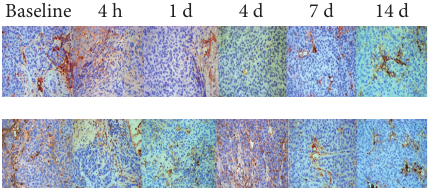
Figure 7: CD34 staining ( × 400) of the tumor at baseline, 4h, 1, 4, 7, and 14 days after treatment in the two groups. From 4 hours and day 1 to day 4, a decrease in the tumor blood vessels and an increase on day 7 and 14 were observed in the M410 treated group (the first line). However, there was no such change in the control group; tumor blood vessels were abundant at all time points in the saline- treated group (the second